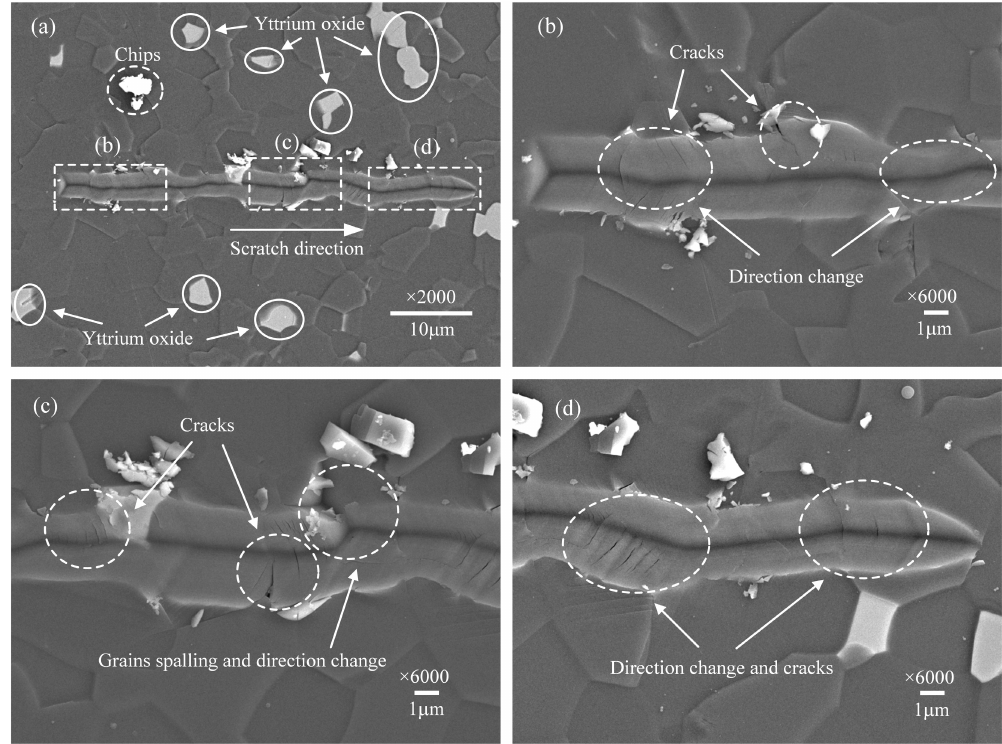
Figure 3. Surface morphology of the scratch groove at the scratch speed of 0.1 μ m/s. ( a ) is the overall morphology. ( b – d ) are detailed enlarged views.